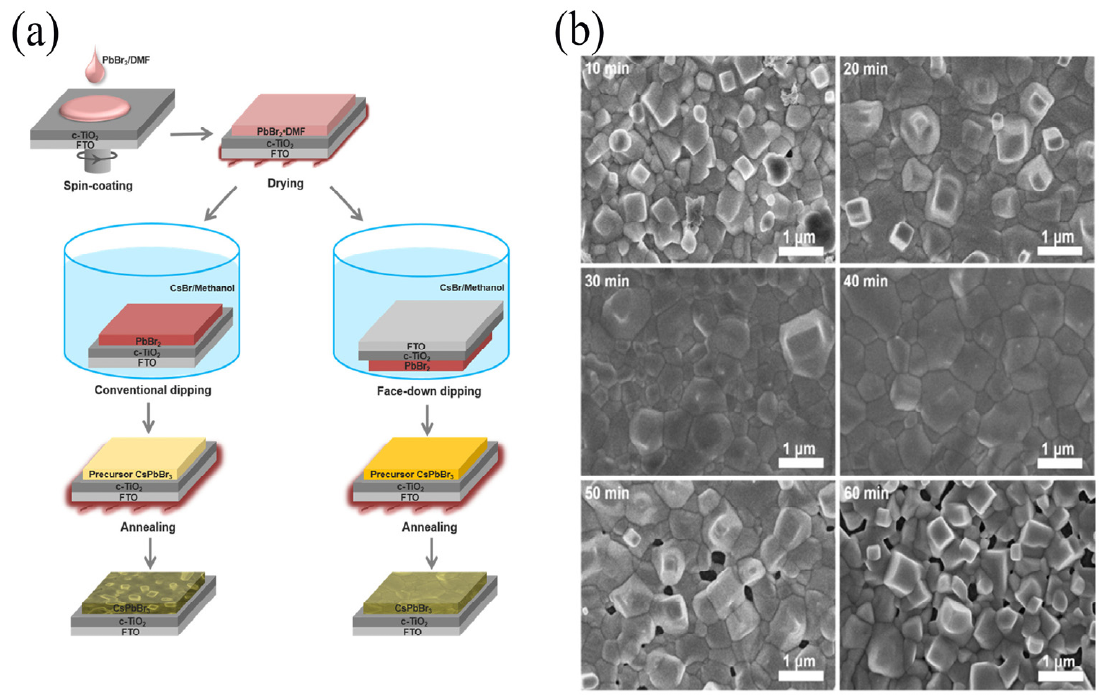
Figure 2. ( a ) Schematic fabrication for CsPbBr 3 films obtained by conventional process and face-down dipping process and ( b ) SEM images of CsPbBr3 perovskite films face-down dipped at 50 °C for 10 min, 20 min, 30 min, 40 min, 50 min, and 60 min, respectively. Reproduced with permission [94]. Copyright 2018, American Chemical Society Publications.